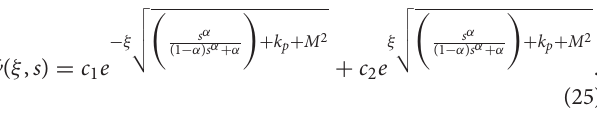
1.5, G m 0.75, P reff = =